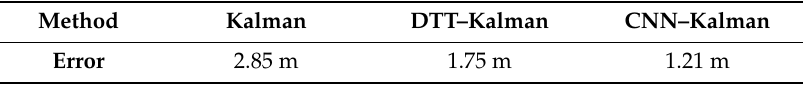
Table 2. Comparison of the end point positioning errors in the indoor track 2